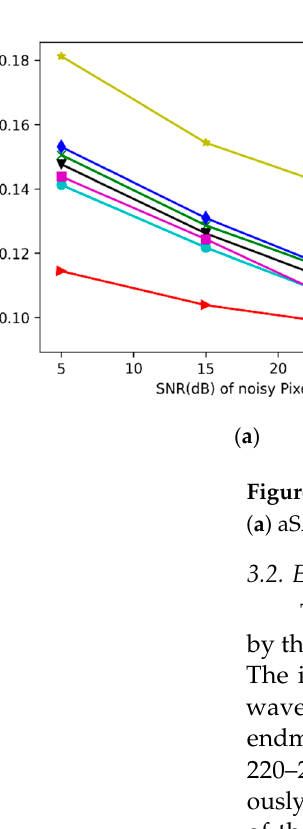
( b ) Figure 6. Robustness evaluation of the unmixing methods with various levels of pixel noise. ( a ) aSAM. ( b ) aRMSE.